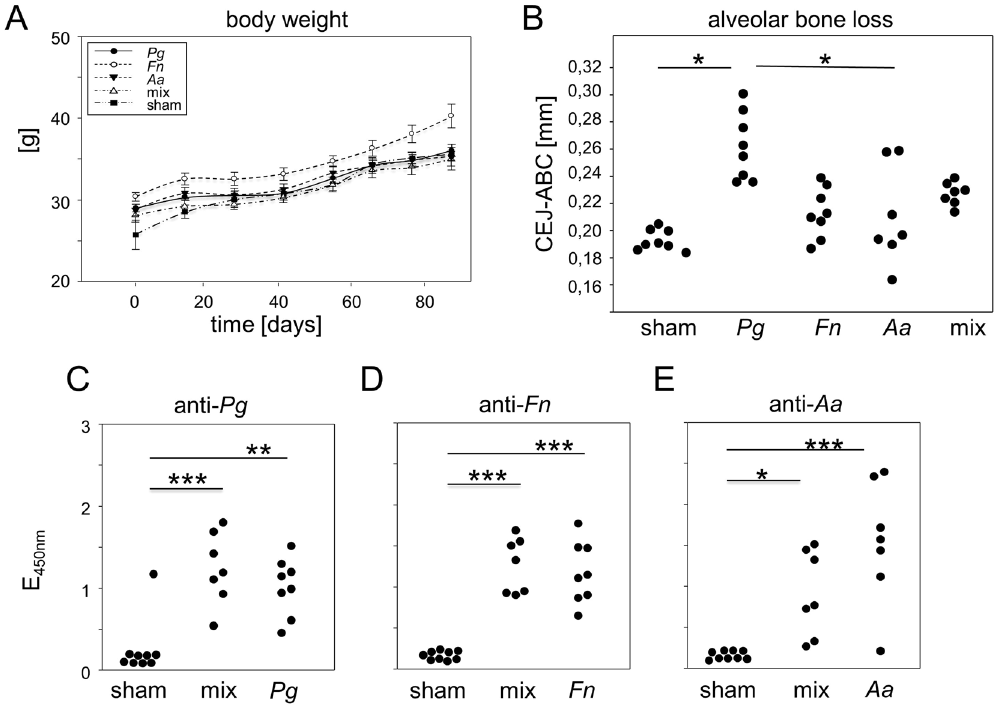
Figure 3. P. gingivalis induced the most severe alveolar bone loss. ( A ) During the experimental period, all mice developed physiologically and gained weight in a comparable fashion. ( B ) Dot plots present the distance from the CEJ-ABC of orally inoculated or sham treated F1 (DBA/1J × B10.Q) mice. ( C – E ) Plots represent antibody titers against oral pathobionts. Pg : P. gingivalis; Fn: F. nucleatum; Aa : A. actinomycetemcomitans ; mix: mice were orally inoculated with a mix of all three pathobionts or just sham treated. Numbers of mice used per group